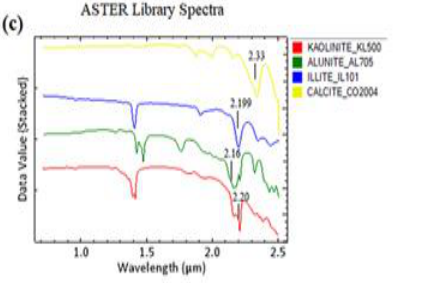
Figure 2: Endmember spectra selected from ASTER and Hyperion images compared to ASTER spectral library and used for spectral analysis